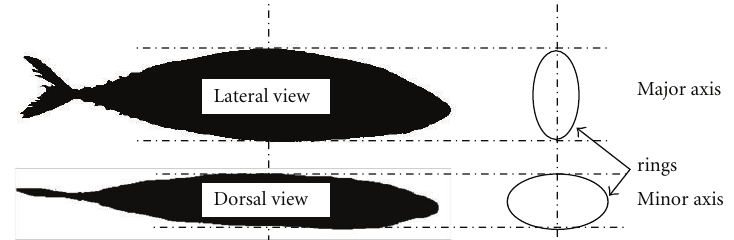
Figure 8: The dimension of the rings used for the